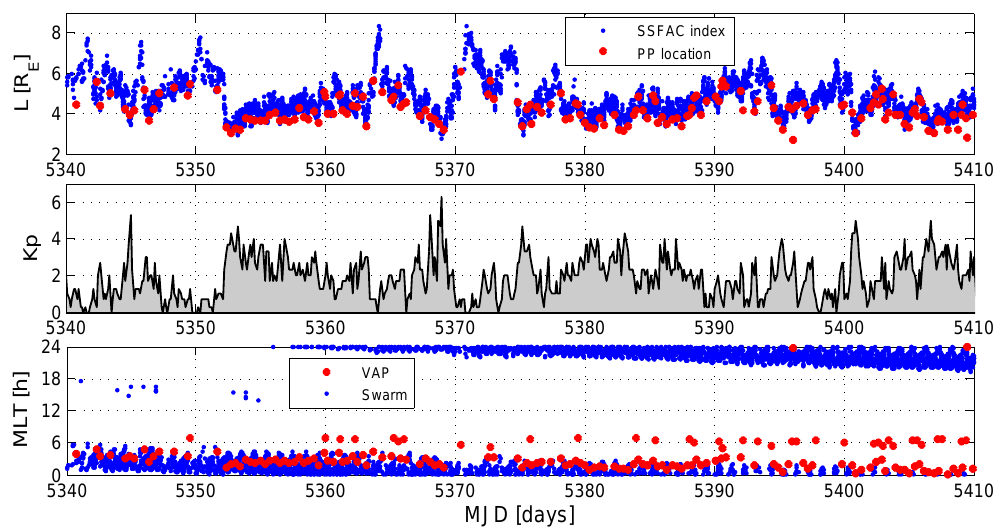
Figure 11. (a) Swarm SSFAC index (blue) and VAP PP_ N e (red) locations, (b) variation of the Kp index, and (c) MLT of the Swarm (blue) and VAP (red)